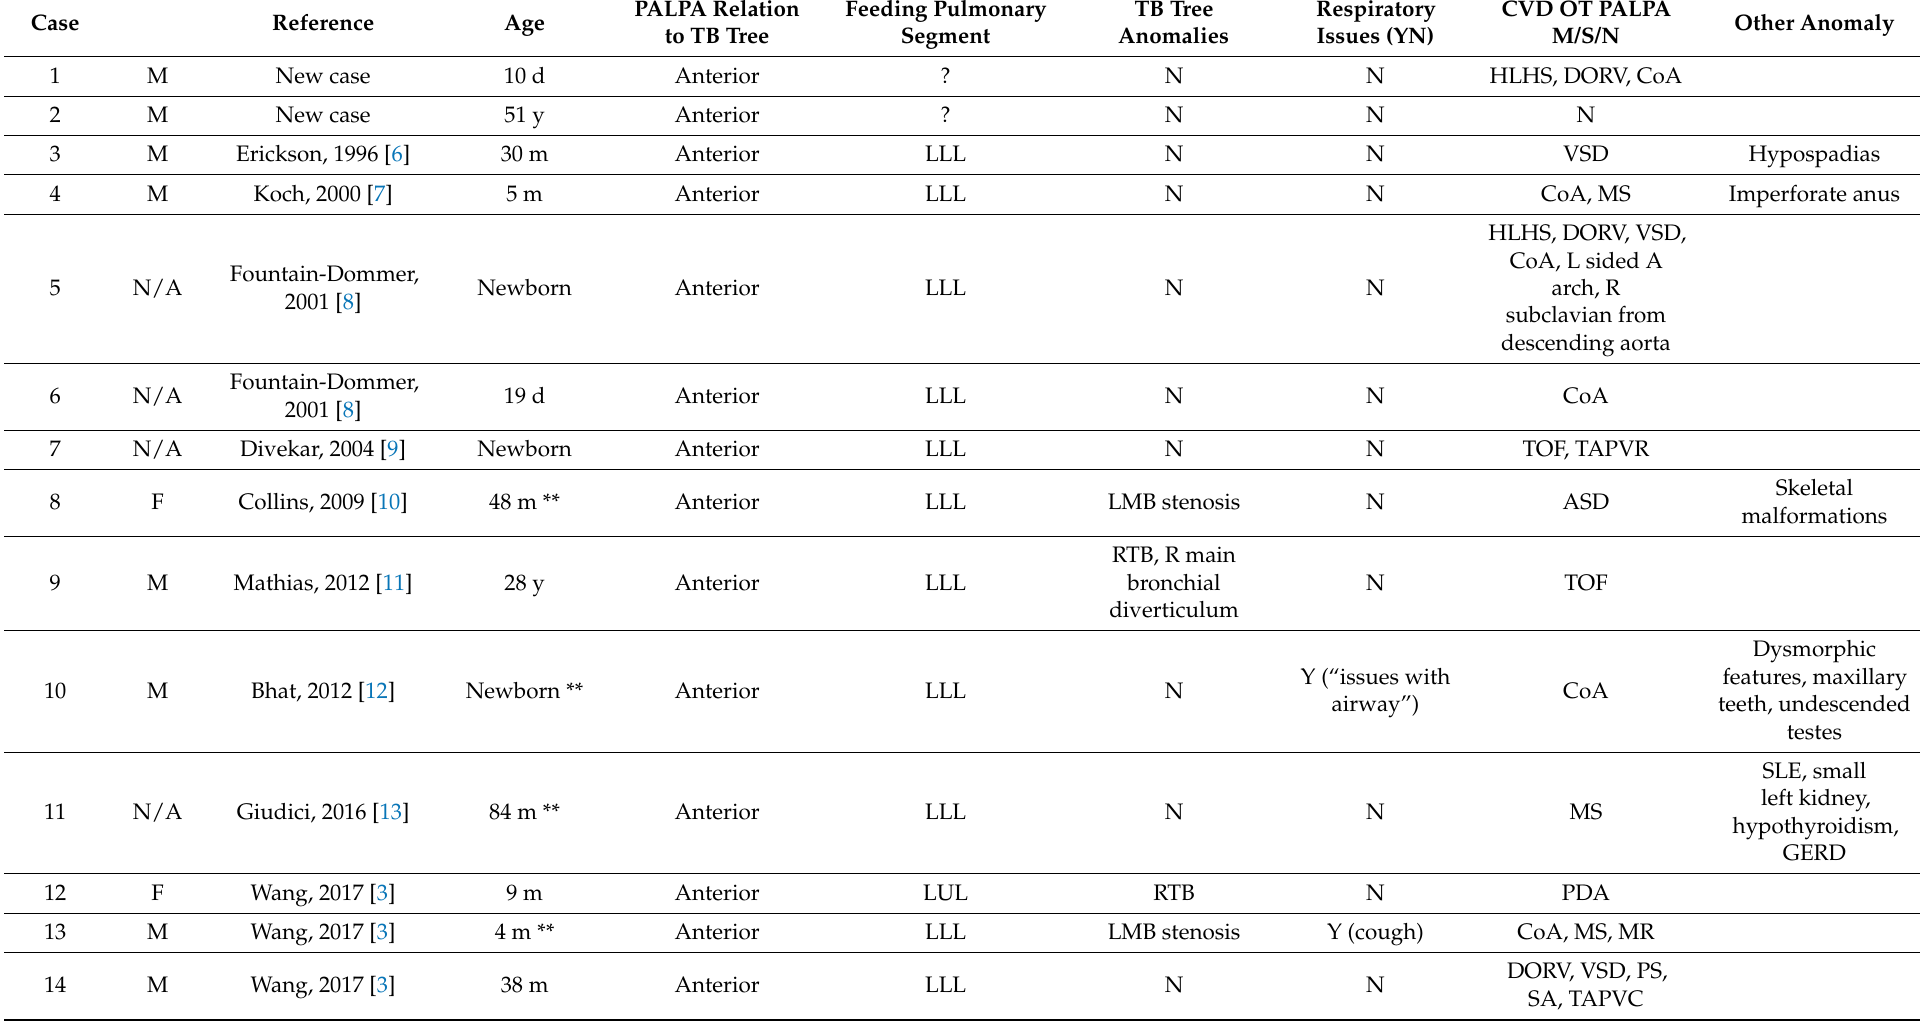
Table 1. Comprehensive table of all cases obtained from the literature ( n = 33) and the teaching institution ( n =